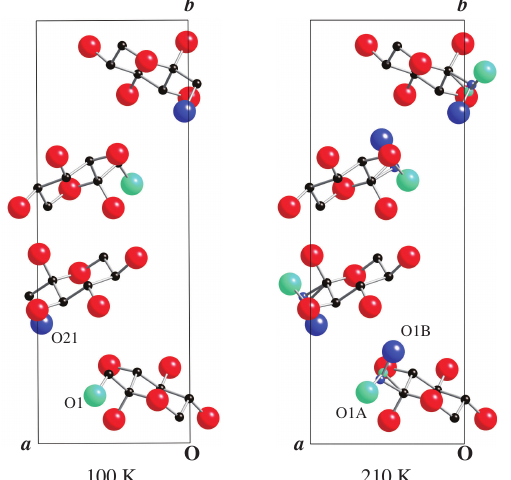
Figure 5. Relative cell constants above the main transition (at 199.5 K) of crystalline D -sorbose. Black plus, a ; red circle, b ; blue cross, c .